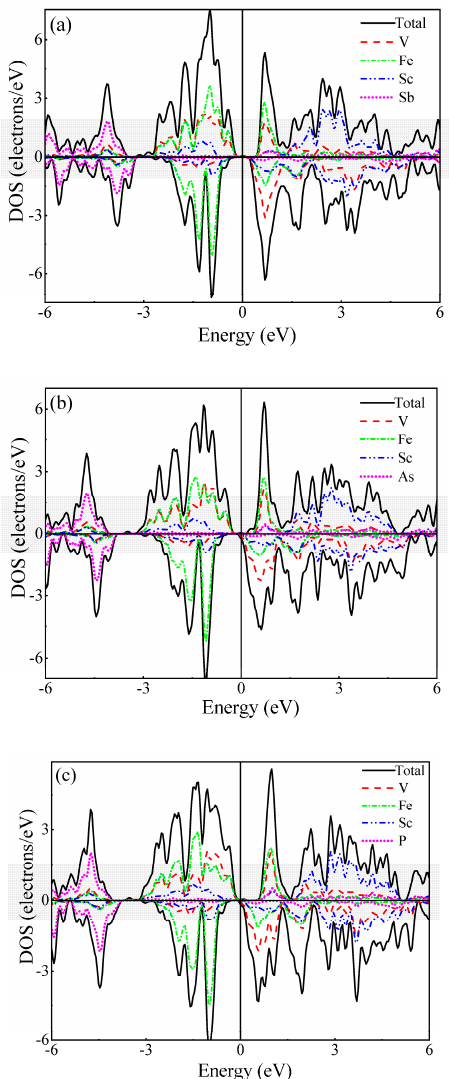
Figure 5. Partial density of states of ( a ) VFeScSb, ( b ) VFeScAs, and ( c ) VFeScP with type-I structure.